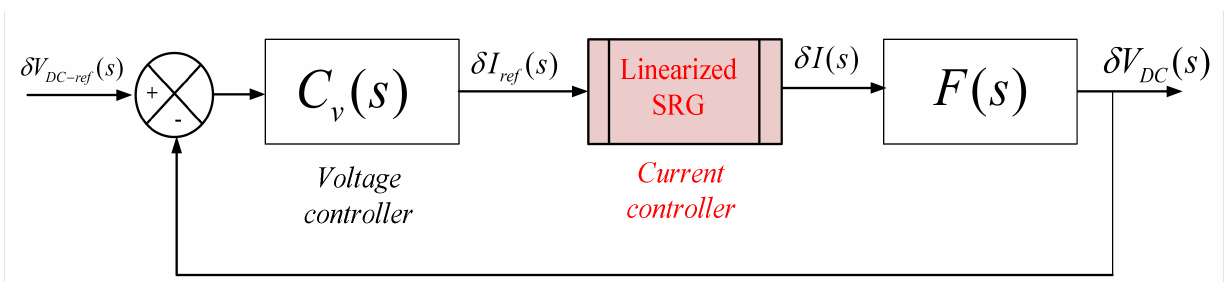
Figure 7. Block diagram of the voltage-controlled SRG